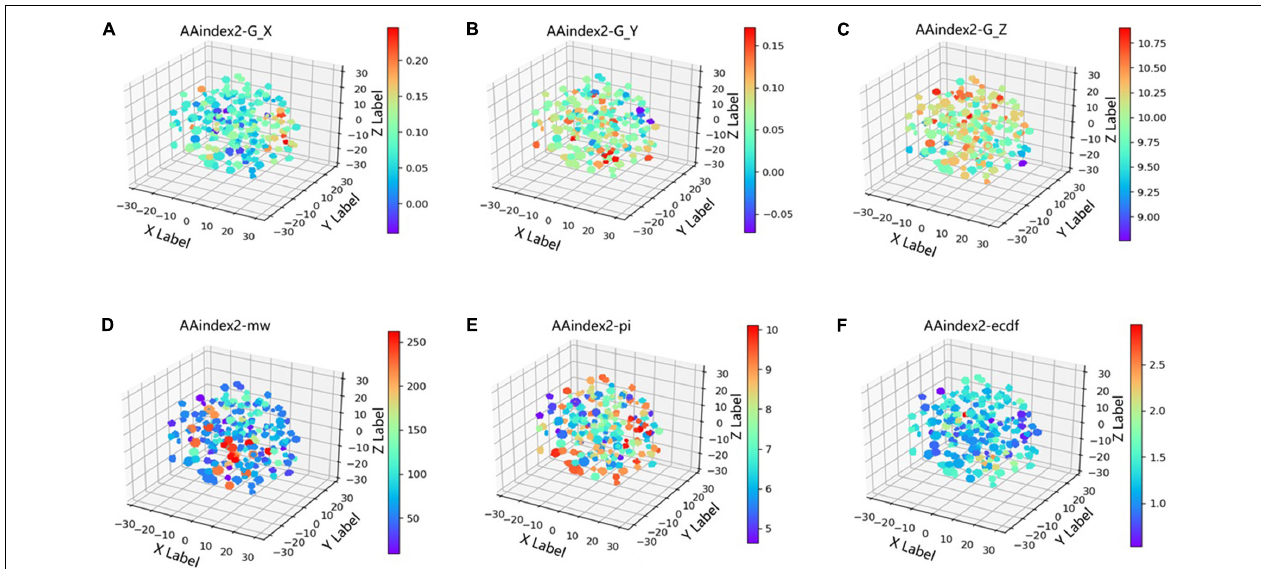
FIGURE 3 | Projected the AAindex2_word2vec from 64-dimensional to 3D space. (A–C) The coordinates of points are the values after dimensionality reduction, and the color is three coefficients derived from the second order gray model. (D–F) The coordinates of points are the values after dimensionality reduction, and the color is isoelectric point(PI), molecular weight (MW), extinction coefficient of different segments (ECDF).